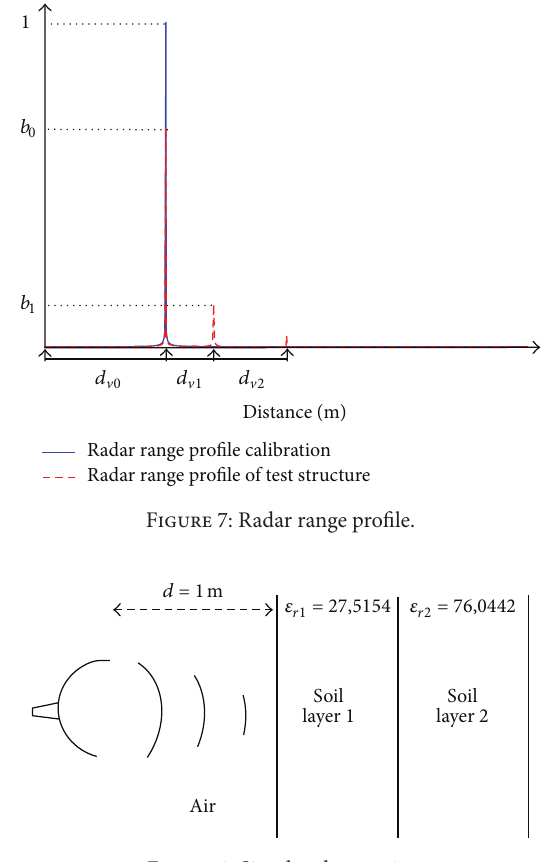
Figure 8: Simulated scenario.